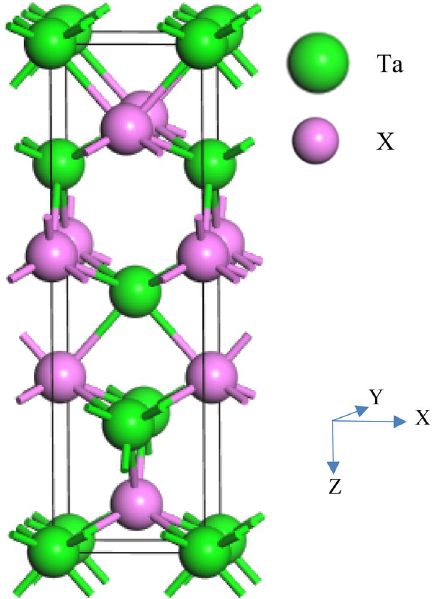
Figure 1. Schematic 3D Crystal structure of Ta X ( X = P, As). The crystallographic directions are shown.